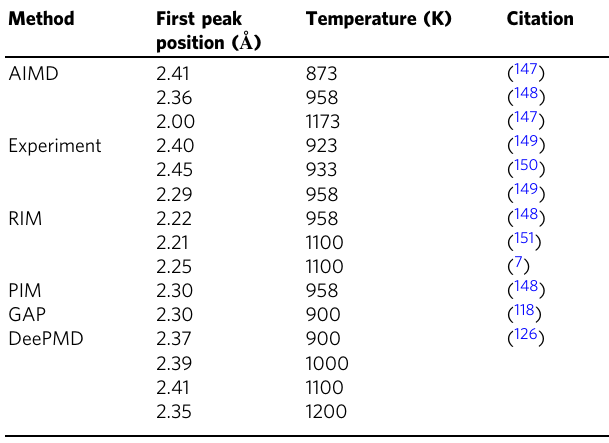
Table 1 LiCl bond-lengths from experiments and